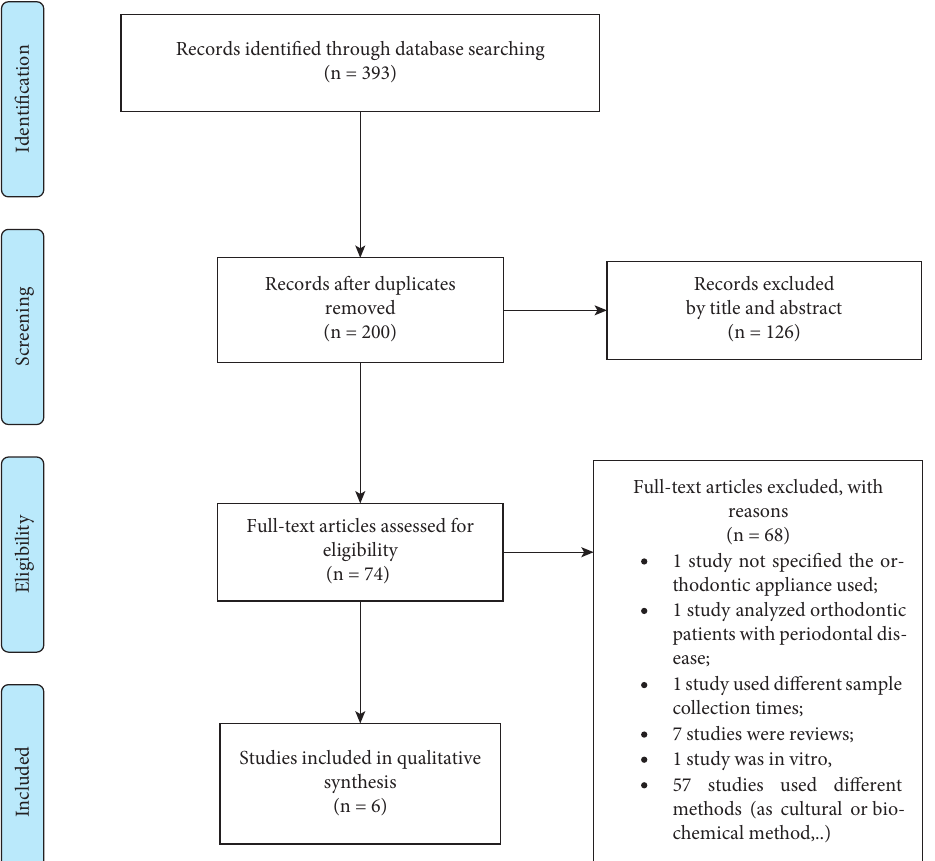
Figure 1: PRISMA flow